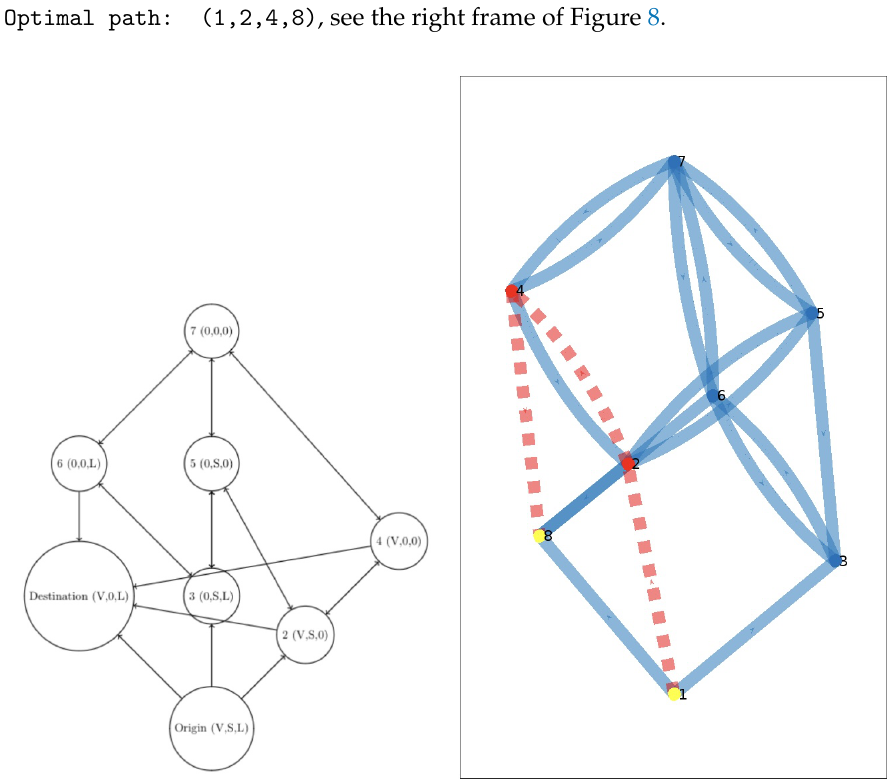
Figure 8. ( Left ): the graph of the ecosystem’s equilibria of [31]. ( Right ): the optimal path